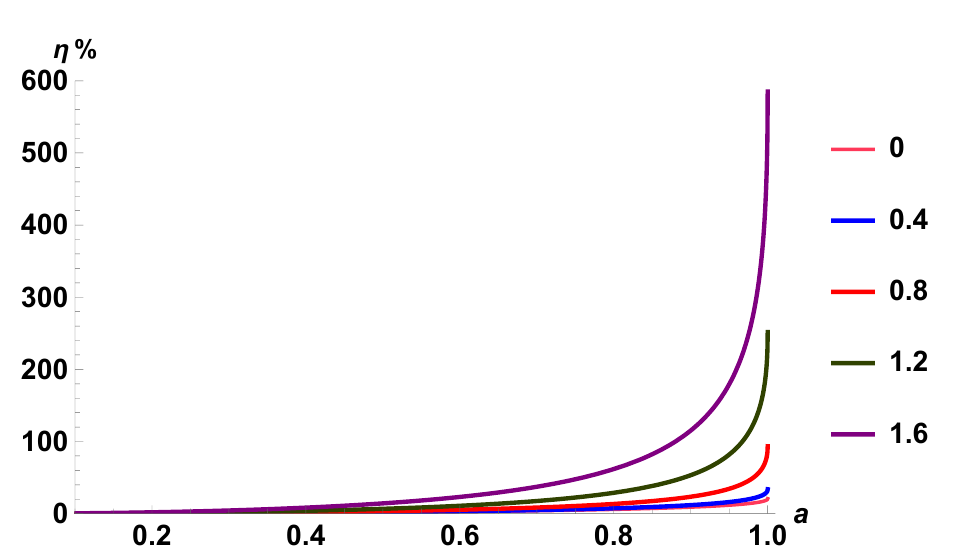
Figure 3. Extraction efficiency vs. spin parameter for a regular black hole. The bar on the right side of the page beside the figure represents the values of the regularisation parameter l , where l = 0 for the Kerr black